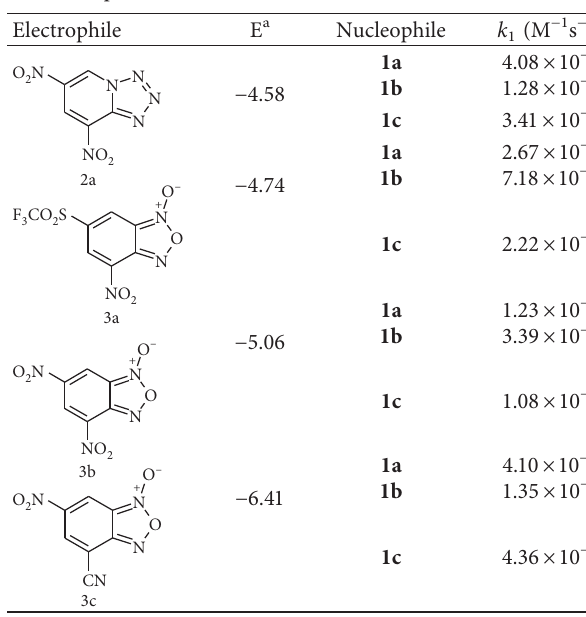
Table 1: Second-order rate constants ( k philicity parameters (E) of the reactions of 3-X-thiophene 1 with the electrophiles 2a and 3a-c in acetonitrile at 20 ° C.